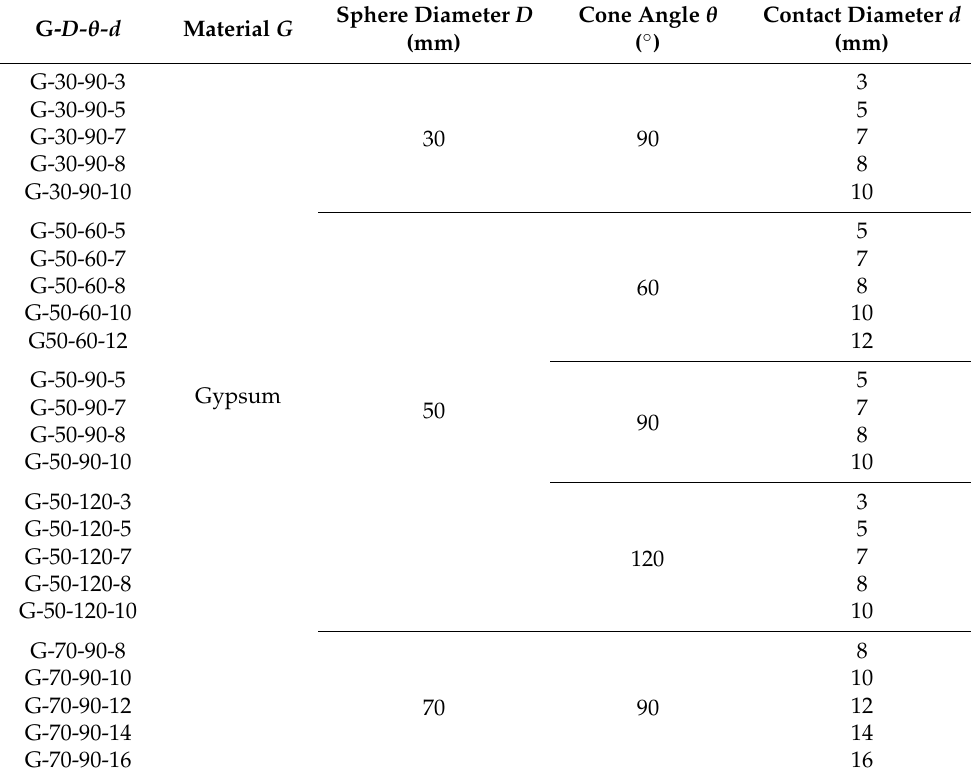
Table 2. Particle groups used in the